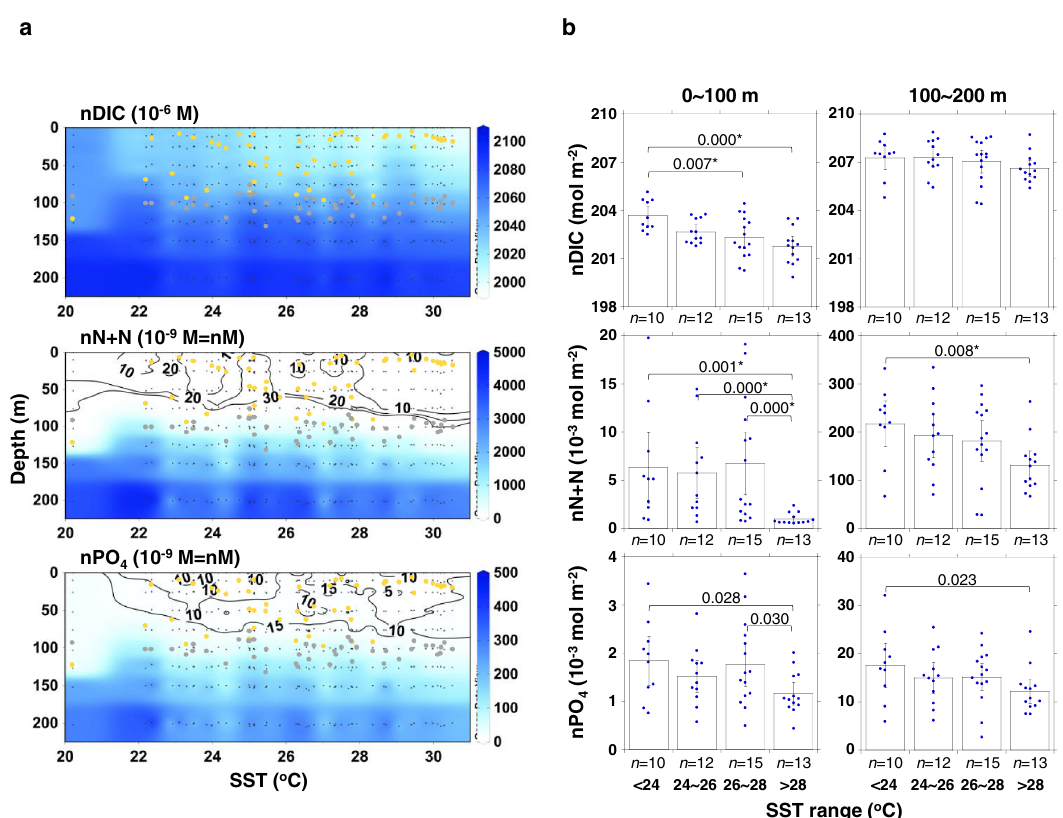
Fig. 2 Distribution of the salinity (39.41) normalized dissolved inorganic carbon (nDIC), nitrate plus nitrite (nN + N), and phosphate (nPO 4 ) over sea surface temperature (SST) in the upper 200 m of the western subtropical North Paci fi c. a Vertical distributions of nDIC, nN + N, and nPO 4 concentrations plotted against SST. The small black dots denote the sampling depths. The yellow and gray solid circles indicate the mixed layer depth (MLD) and euphotic zone depth (EZD), respectively. The black contour lines in the nN + N and nPO 4 panels represent nanomolar gradients of ~30nM (10nM interval) and ~15nM (5nM interval), respectively. b Integrated stocks of nDIC, nN + N, and nPO 4 in four different SST regimes within the 0~100m (left) and 100~200m (right) layers. Bar charts represent mean values of the integrated stocks indicated as blue dots. The error bars denote the 95% con fi dence interval (CI). Signi fi cant differences (two-sided Kruskal-Wallis test, P < 0.05) in the mean stocks between the SST regimes are depicted just above the bars. Signi fi cant differences of multiple comparisons with the Dunn ’ s procedure after the Kruskal-Wallis test ( P < 0.0083) are marked with an asterisk